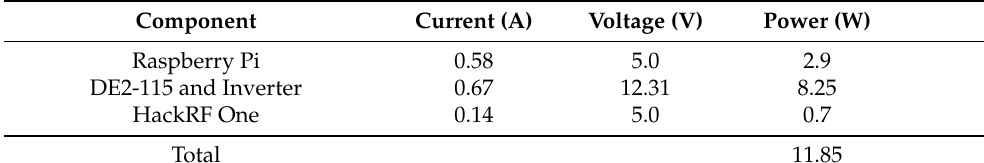
Table 1. Current and voltage requirements for project